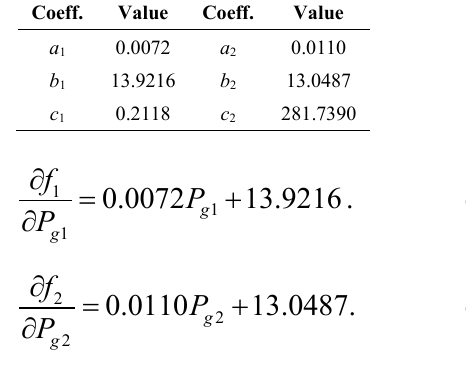
TABLE I E VALUATED V ALUES OF C OEFFICIENTS AFTER Q UADRATIC R EGRESSION Coeff.